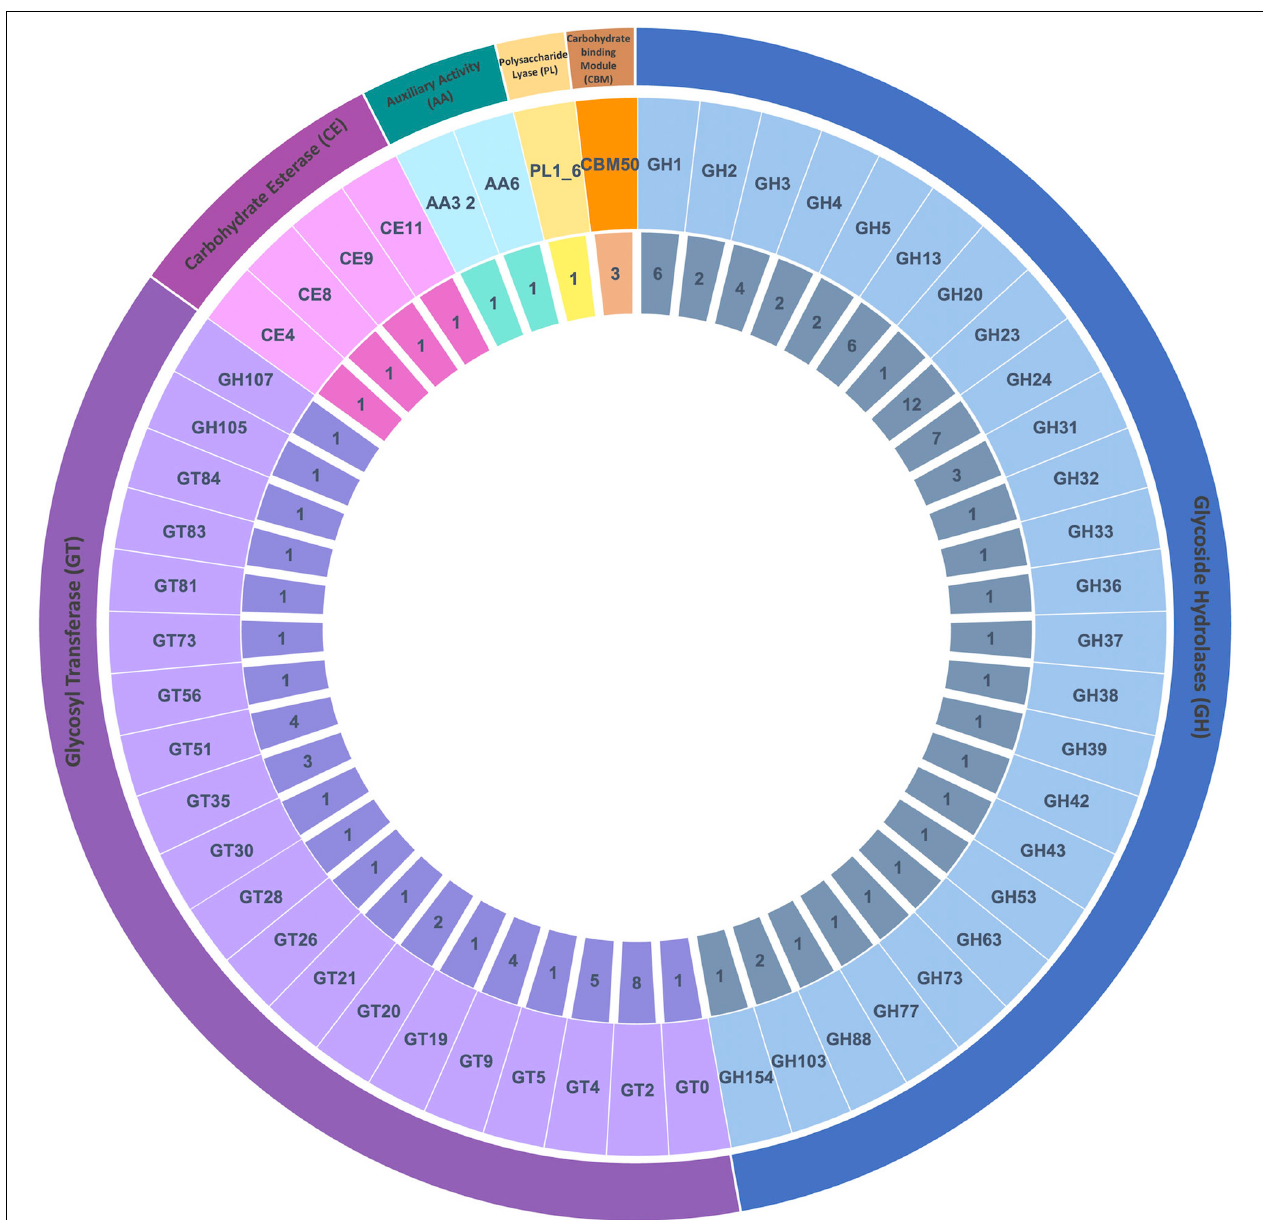
FIGURE 1 | Distribution of CAZyme families from Rahnella sp. ChdrAdgB13. Genomic sequences predicted: 25 glycoside hydrolases (GH), 20 glycosyl transferases (GT), four carbohydrate esterases (CE), two auxiliary activities (AA), one polysaccharide lyases (PL), and one carbohydrate-binding module 50 (CBM50 associated with proteins LysM). From inner to outer rings are the numbers of genes and CAZyme families and classes,